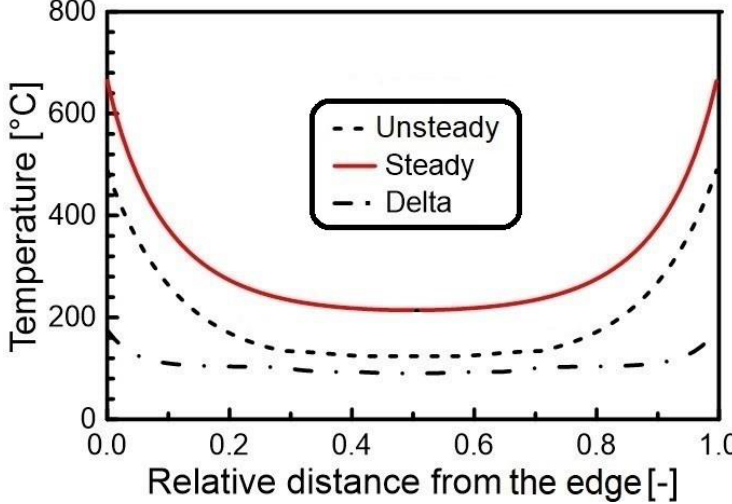
Figure 5. Transversal temperature profiles calculated at the final stage of the fire test (60 min) using steady- and unsteady-state FEM methodologies. Delta: temperature difference between the two anal- yses.